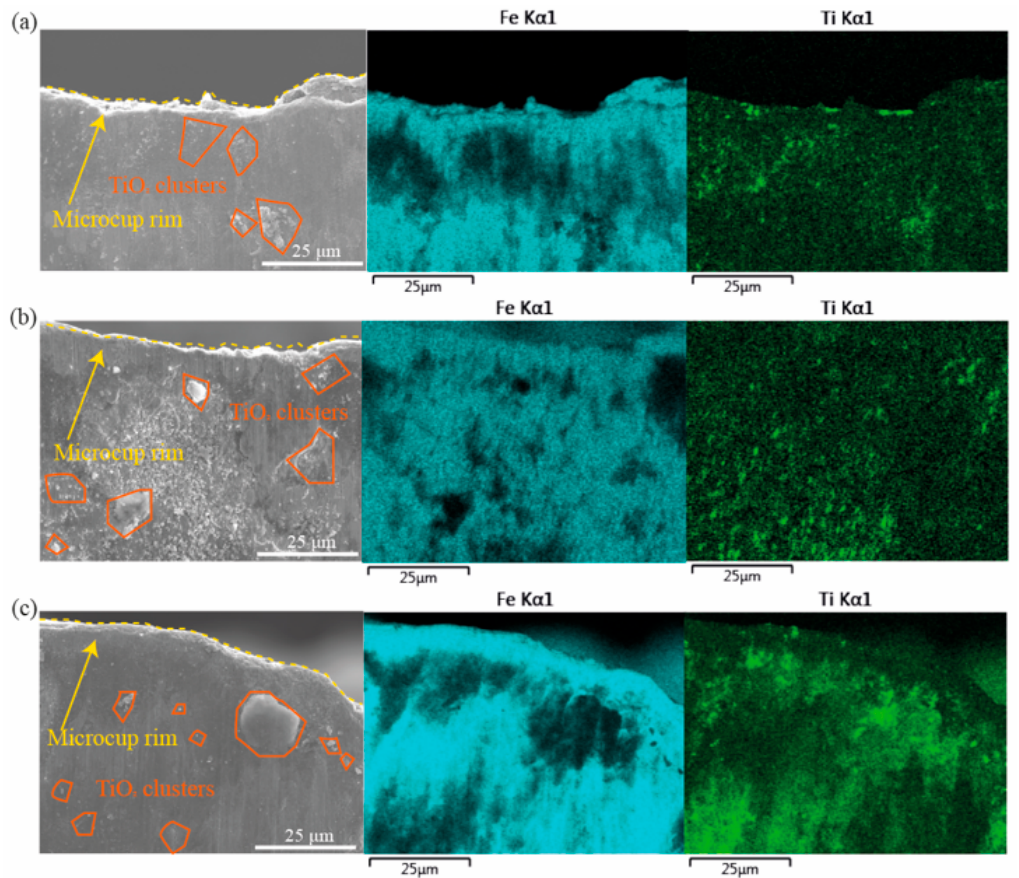
Figure 12. SEM images and EDS mappings of the micro cups mouth lubricated by ( a ) 1 wt% TiO 2 nanolubricant, ( b ) 2 wt% TiO 2 nanolubricant, and ( c ) 4 wt% TiO 2 nanolubricant.